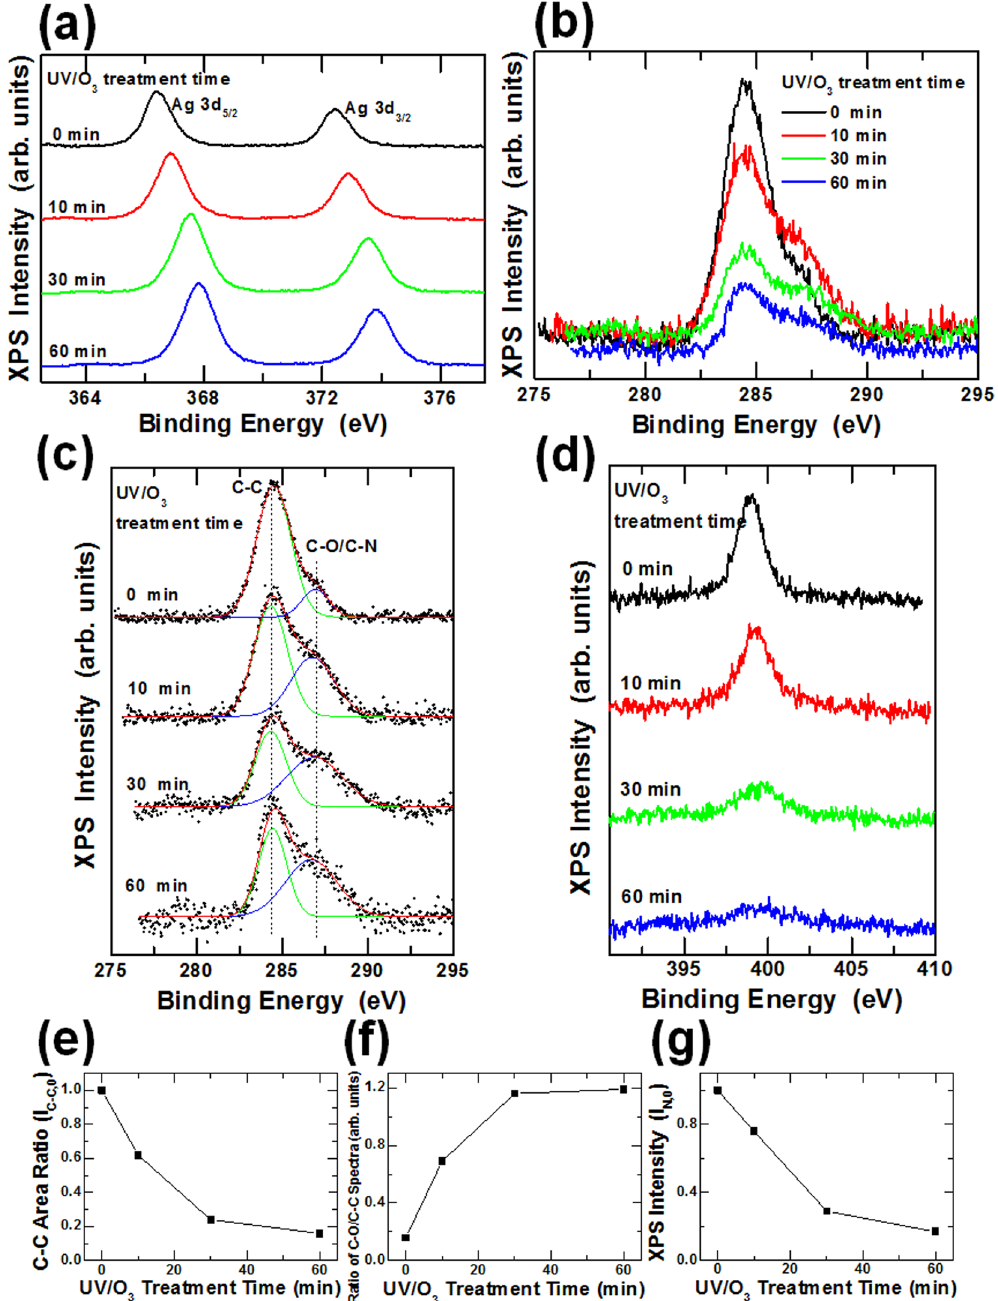
Figure 4. X-ray photoelectron spectroscopy spectra of the Ag NWs heat-treated for 0, 10, 30, and 60 min: ( a ) Ag 3d, ( b ) C 1s, ( c ) C 1s. ( d ) N 1s spectra of the Ag NWs heat-treated for 0, 10, 30, and 60 min. ( e ) Normalized C-C spectral area as a function of the UV/O 3 treatment time, and ( f ) C-O/C-N spectral area ratio based on the C-C spectral area as a function of the UV/O 3 treatment time. ( g ) N 1s peak intensity as a function of the UV/O 3 treatment